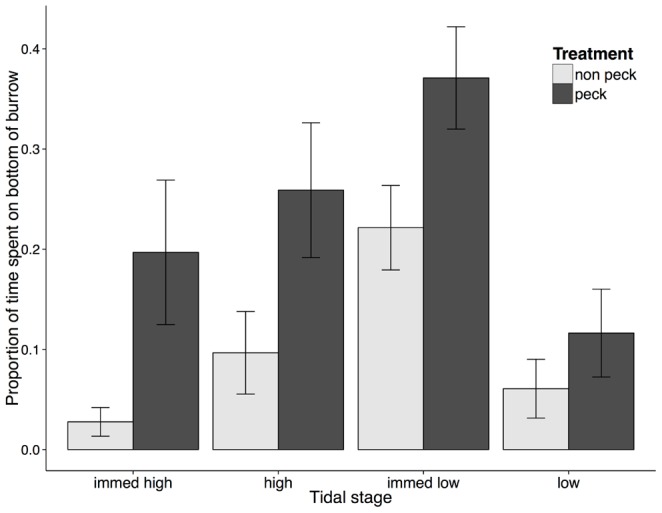
Proportion of time spent by focal Corophium volutator females on the bottom of their burrows in the presence and absence of simulated shorebird predation in laboratory.Clustered bars represent paired treatment levels (pecking and non-pecking) for each of four simulated tidal stages (immediately high, high, immediately low, and low). Proportion of time was calculated from 80 min of observation time per experimental unit and tidal stage. Experimental units in the pecking treatment level experienced 5 min of simulated pecking (1 peck per s) at the start of immediately low tide. Values are mean ±1 SE (n = 6 experimental units).